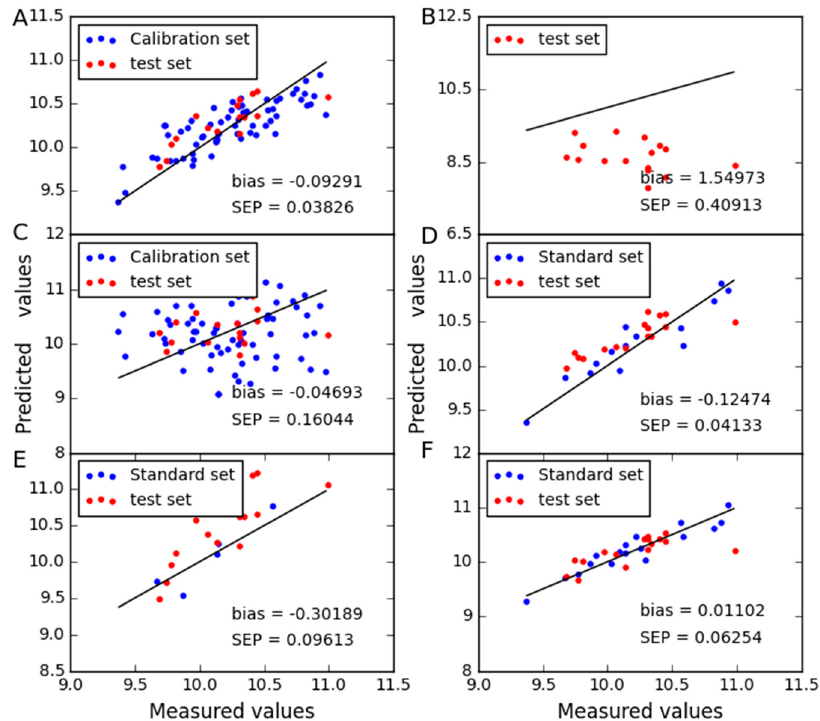
Figure 3. Moisture content predicted for corn dataset as determined by ( A ) CTAI, ( B ) MSC, ( C ) TCR, ( D ) CCA, ( E ) SBC and ( F ) PDS. The blue and red dots represent the results for each sample in the train set and test set, respectively.